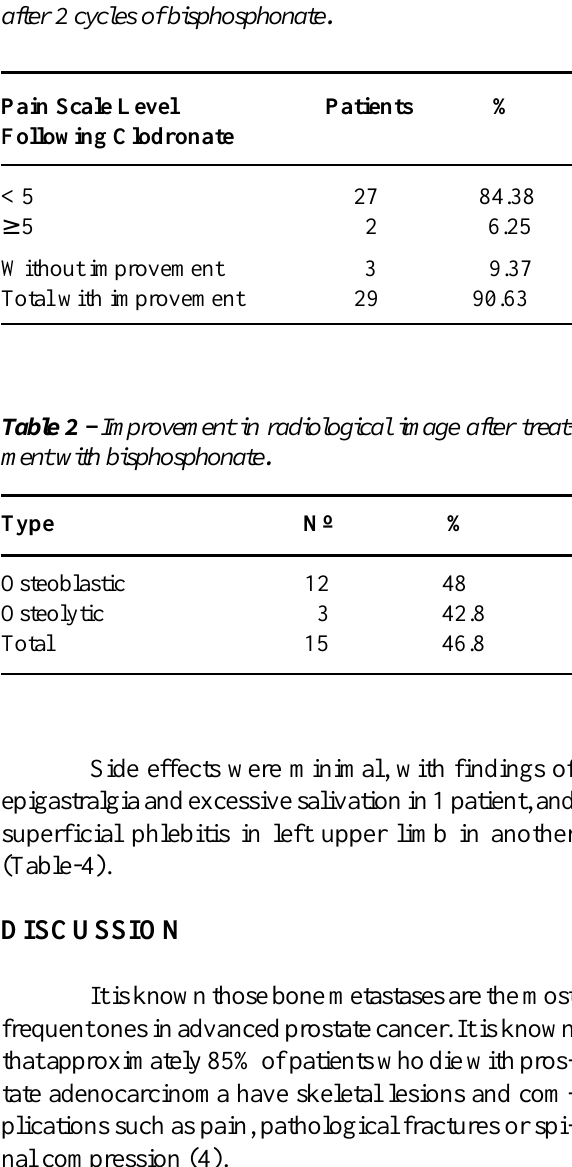
Table 1 - Improvement in pain according to visual scale after 2 cycles of bisphosphonate.